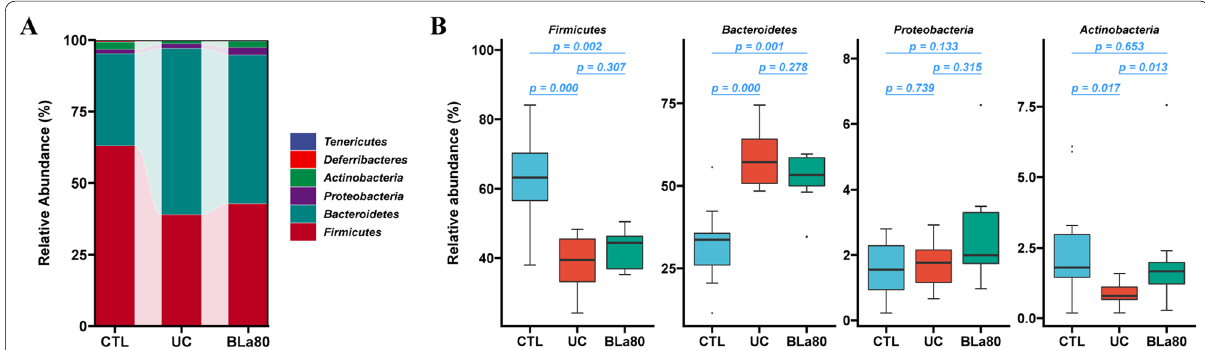
Fig. 5 Effect of BLa80 intervention on the abundance of gut microbiota in UC mice. Alluvial plot ( A ) and changes in abundance ( B ) at the phylum level